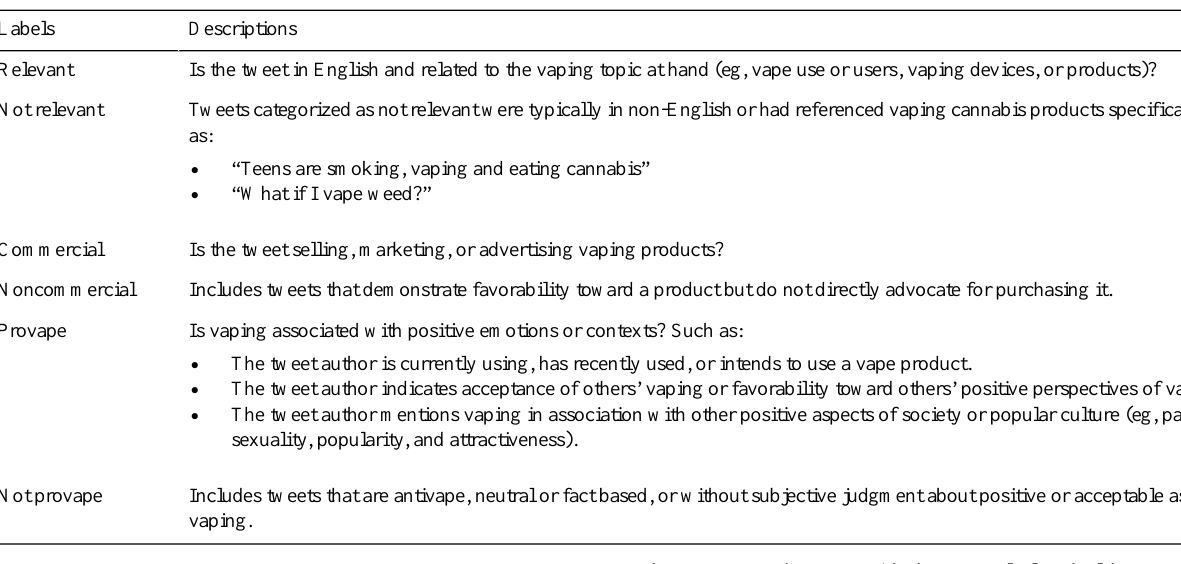
Table 1. Descriptions of labels used for annotating vaping-related